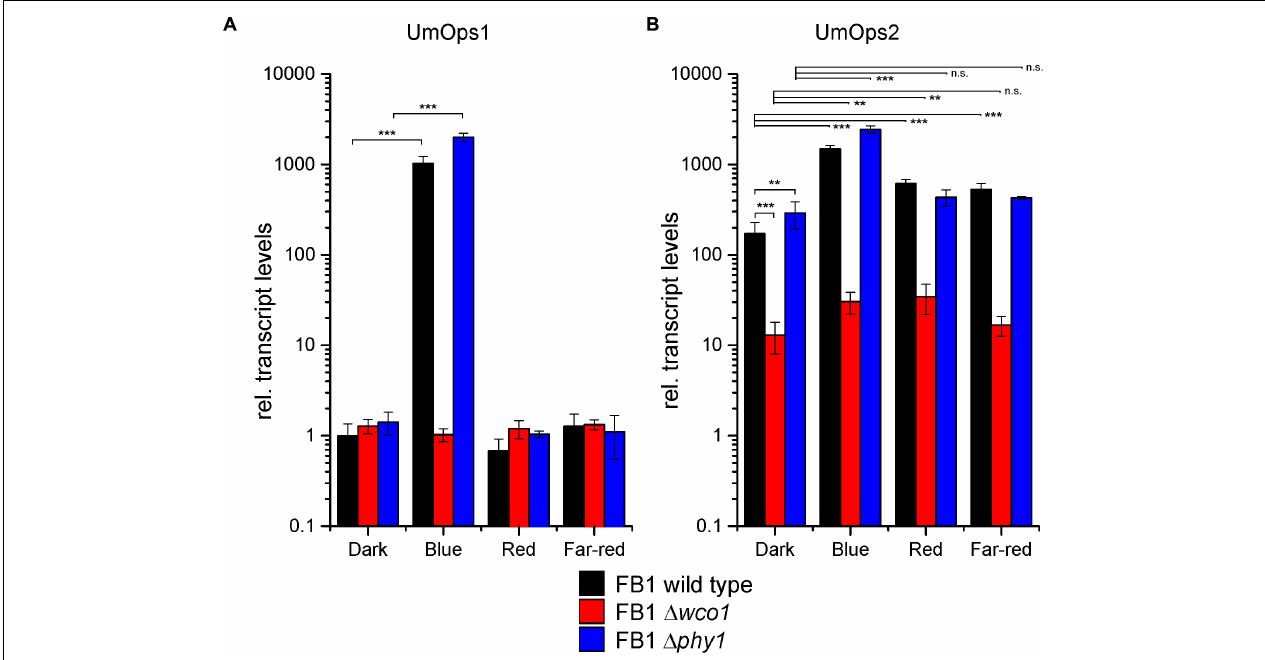
FIGURE 1 | Light regulation of (A) Um ops1 and (B) Um ops2 expression. Transcript levels were quantified by qRT-PCR. FB1 cells were grown in complete darkness and then illuminated with monochromatic lights at a fluence rate of 10 µ mol/m 2 /s 1 for 1 h. Transcript levels were normalized against the one of Um ops1 in dark-grown wild type and cyclophilin. Shown are means and SD of three biological replicates kept in darkness or illuminated with either blue ( λ max 471 nm), red ( λ max 664 nm), or far-red ( λ max 740 nm) light as indicated. Significance levels between group samples are indicated for p -values over 0.05 with not significant (n.s.), for < 0.05 with one asterisk ( ∗ ), for < 0.01 with two asterisks ( ∗∗ ), and for < 0.001 with three asterisks ( ∗∗∗ ). Note that relative transcript levels are given in logarithmic scale.